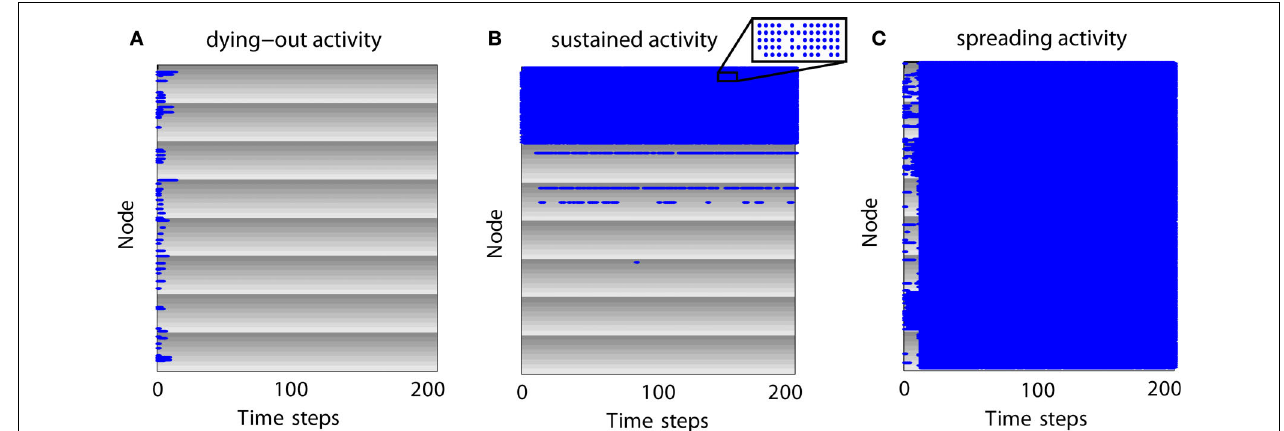
FIGURE 3 | Examples of neural dynamics for different simulation outcomes. Gray shading represents modules and individual gray levels represent different sub-modules. Nodes which are active at a time step are represented as blue dots.